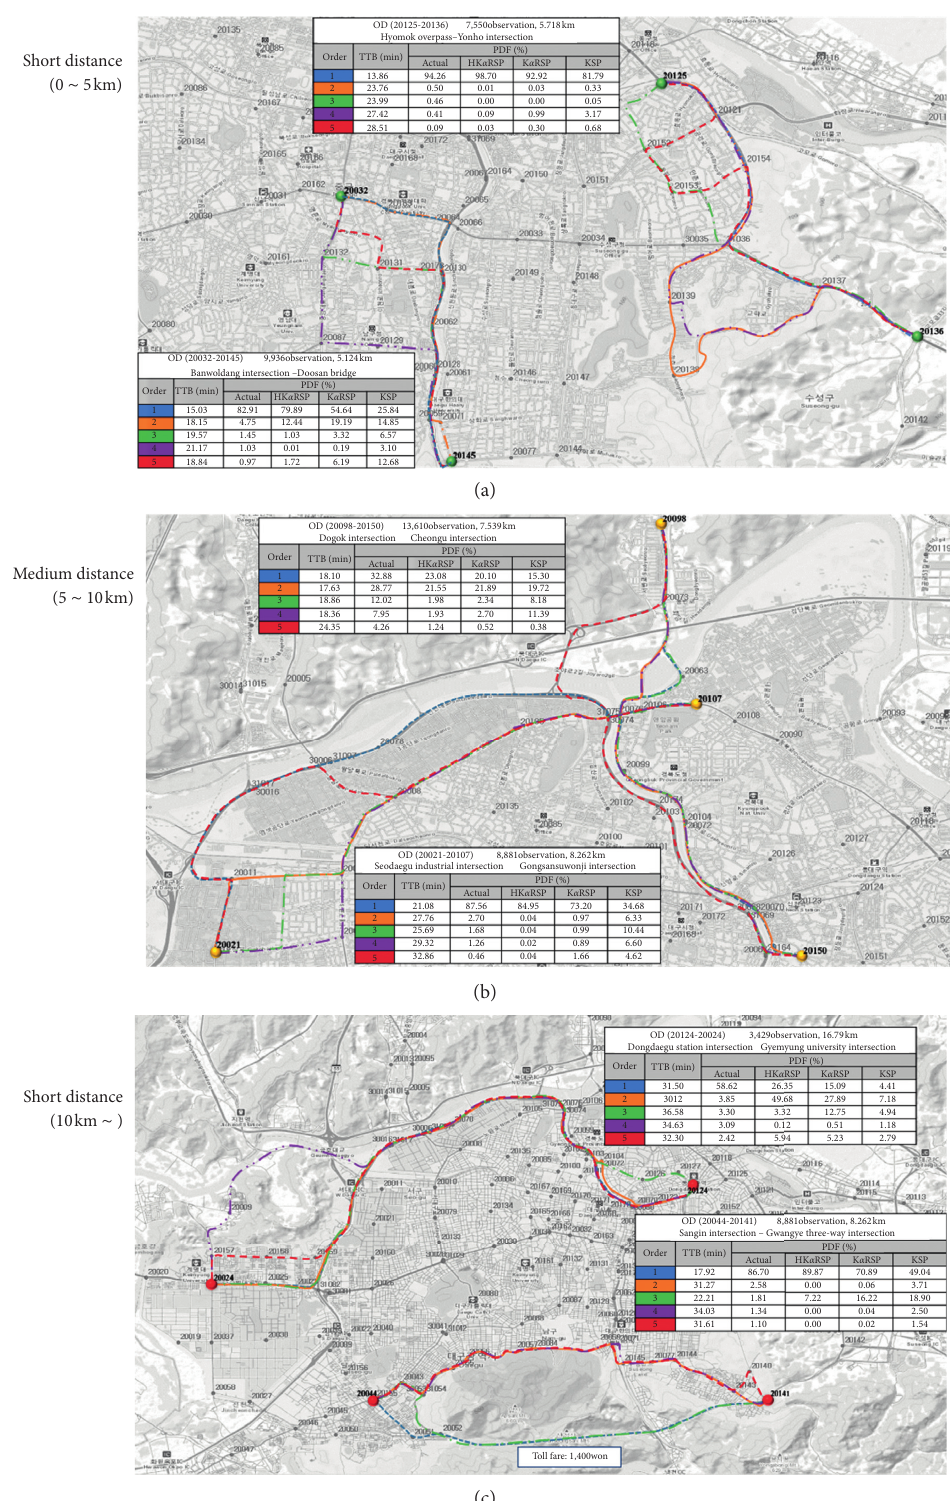
Figure 5: Model validation considering travel